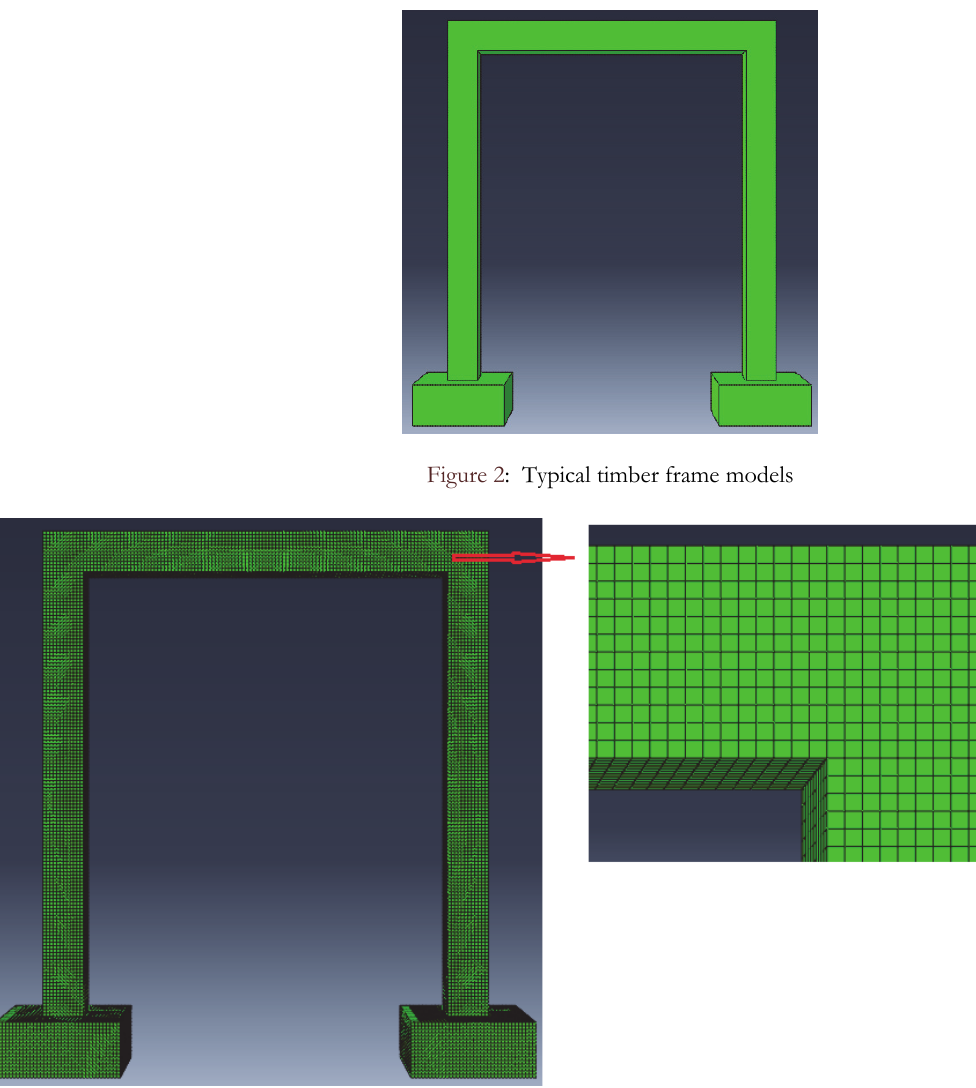
Figure 3: Typical timber frame models, with mesh is used in numerical